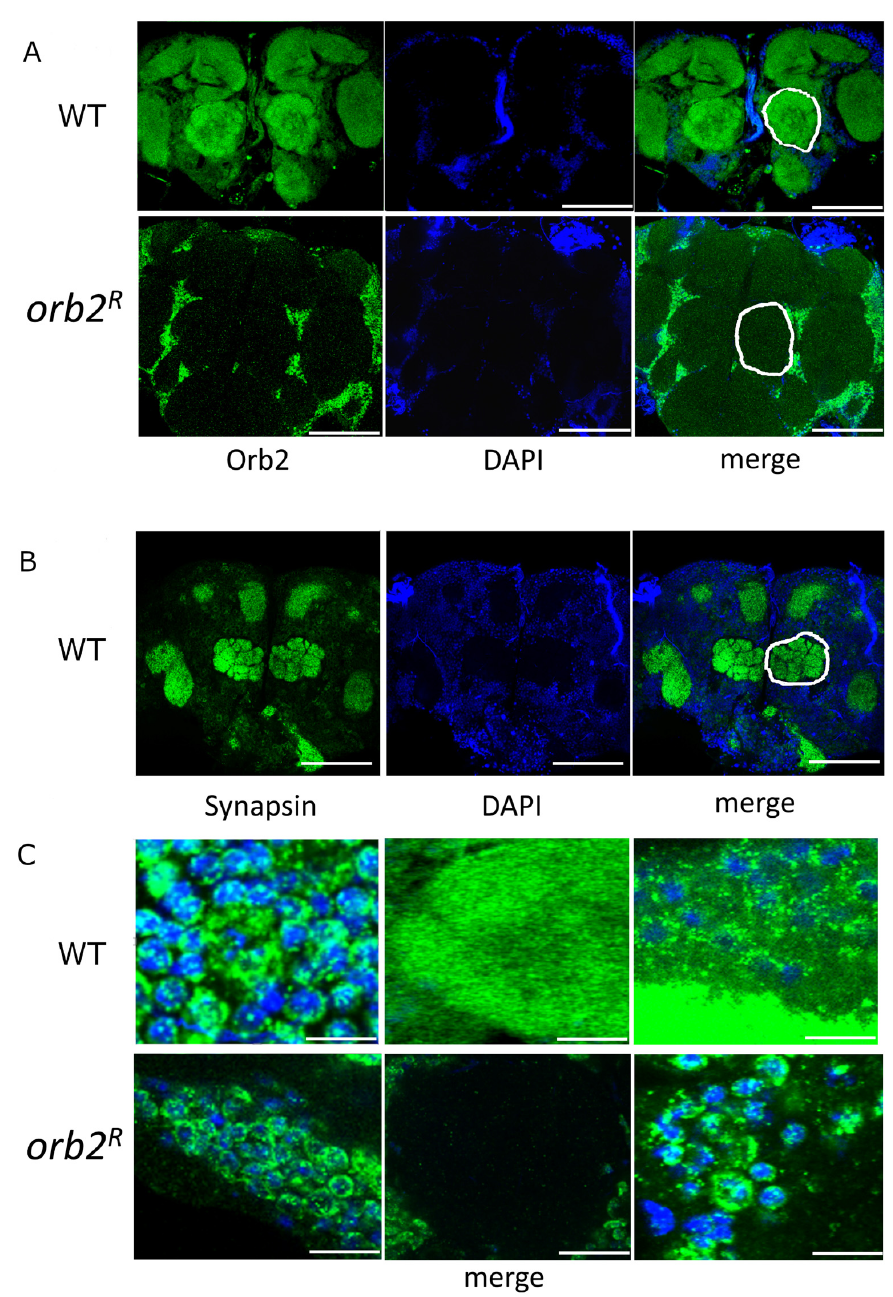
Figure 4. Distribution of the Orb2 protein in the brain of Drosophila in WT and orb2 R mutants. ( A ) Staining of the entire brain of Drosophila with antibodies against the Orb2 protein (green) and DAPI (blue). The images were obtained with equal exposure. A white line shows the neuropile region. Scale bar, 100 µm. ( B ) Staining of the WT fly brain with anti-Synapsin antibody to visualize the major neuropile regions (one of them is marked with a white line). Scale bar, 100 µm. ( C ) Enlarged images of the neuron soma region (left) and neuropile region (middle) in samples of WT and Orb2 R flies. Merged images are shown. On the right are long-exposure images to visualize soma and neu- ropil regions in the same image. Whole brain images for these panels are given in the Supplement (Figures S1–S6). Scale bars for top images are 5, 20, and 5 µm (from left to right). Scale bars for bottom images are 10, 10, and 5 µm (from left to right).